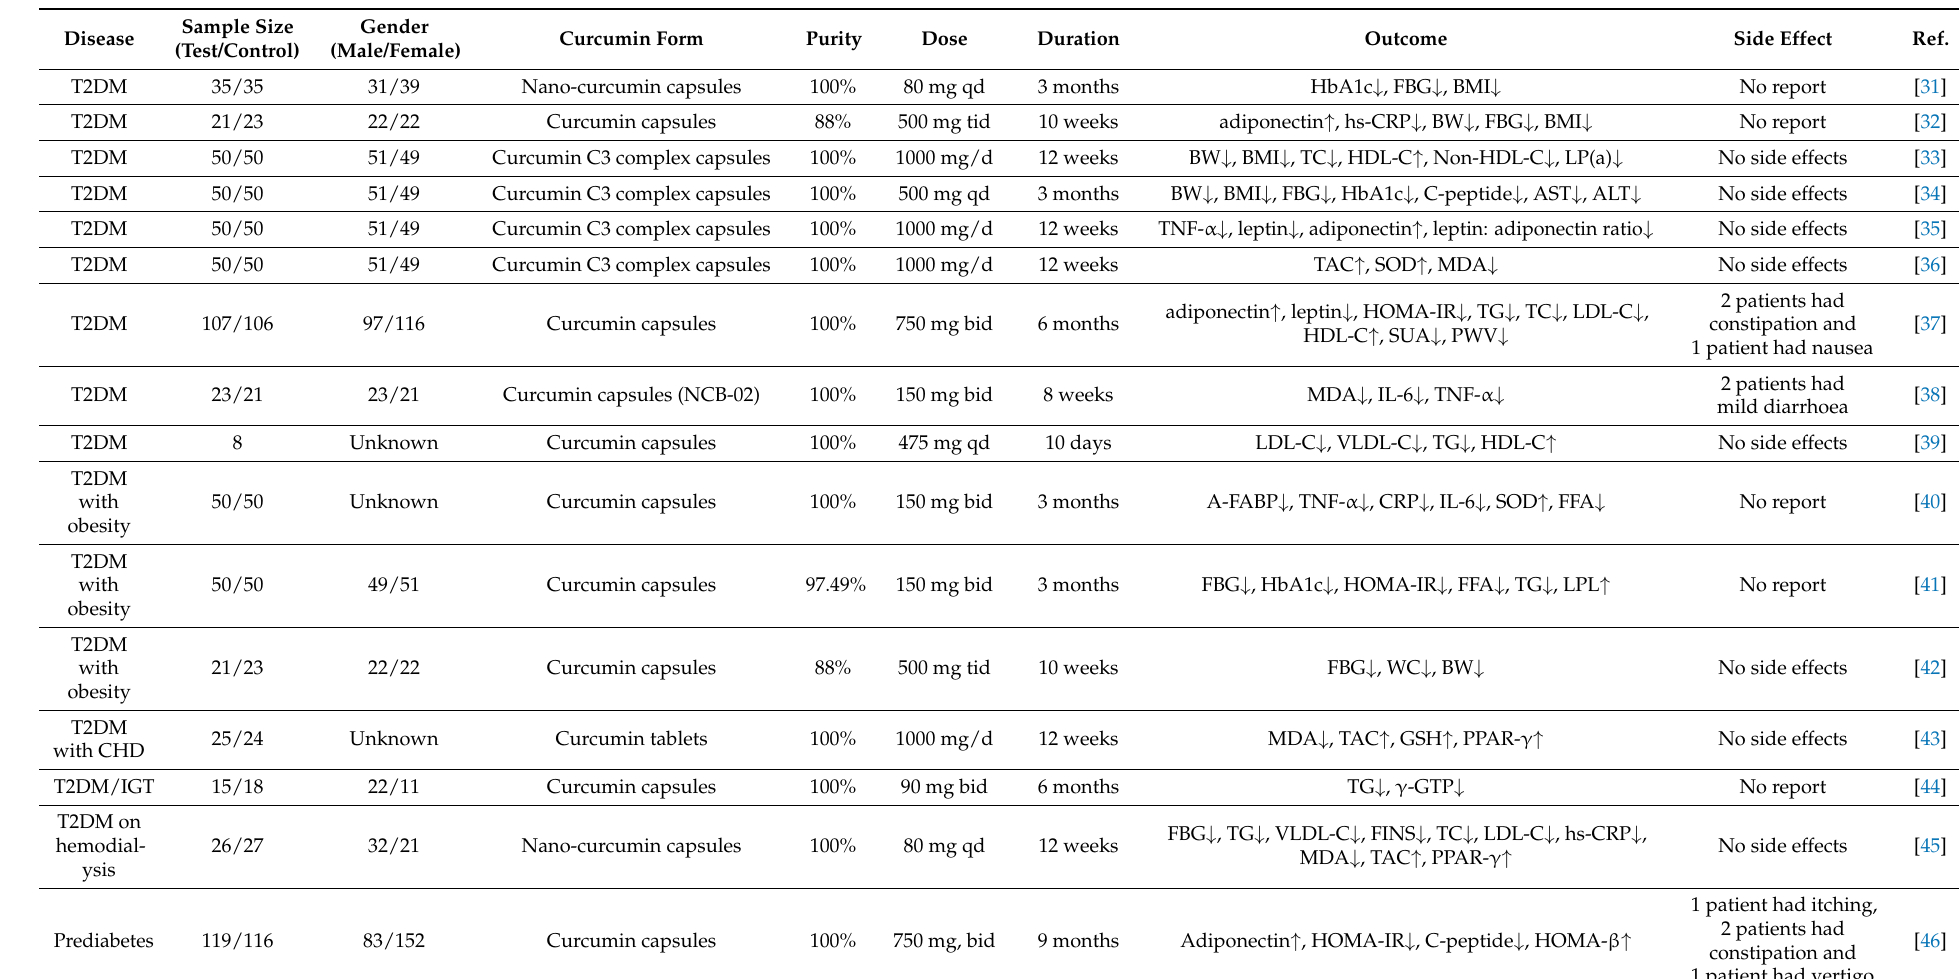
Table 2. Published clinical trials of curcumin in the treatment of metabolic diseases.